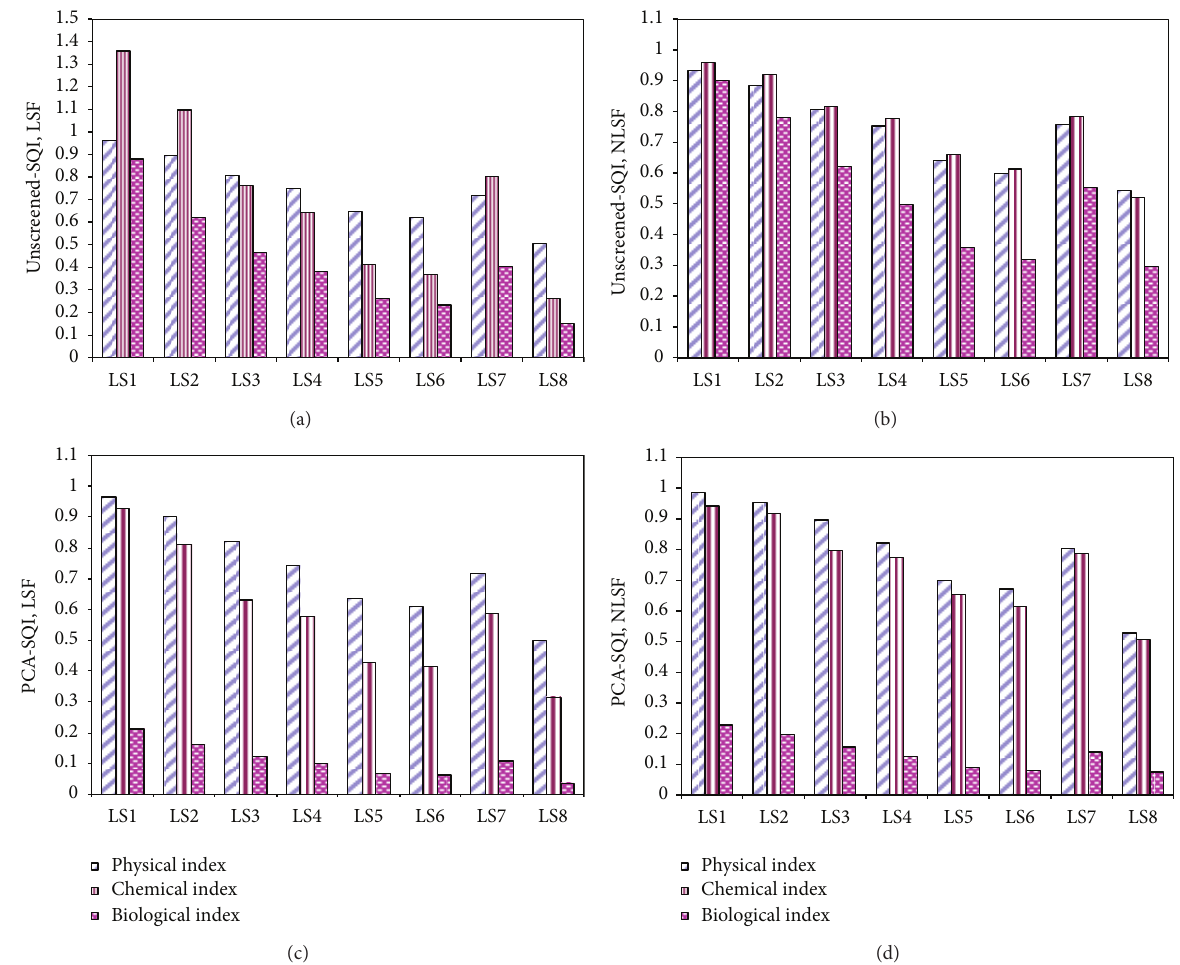
Figure 3: LUSMS effects on mean physical, chemical, and biological soil quality indicator scores for different indexing methods within the Mai-Negus catchment of northern